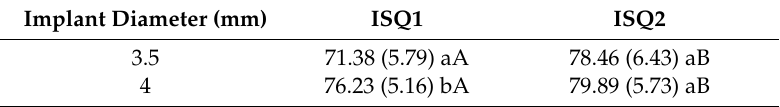
Figure 4. ISQ 1 and 2 values distribution within different maxilla regions (frontal and posterior). Table 2. Tukey’s multiple comparison test of ISQ1 and ISQ2 values for 3.5- and 4-mm diameter implants. Numbers are means and values in brackets are standard deviations. Lowercase letters indicate statistically significant differences among the diameter within the ISQ 1 or 2 values. Uppercase letters indicate statistically significant differences between the ISQ 1 or 2 values within the